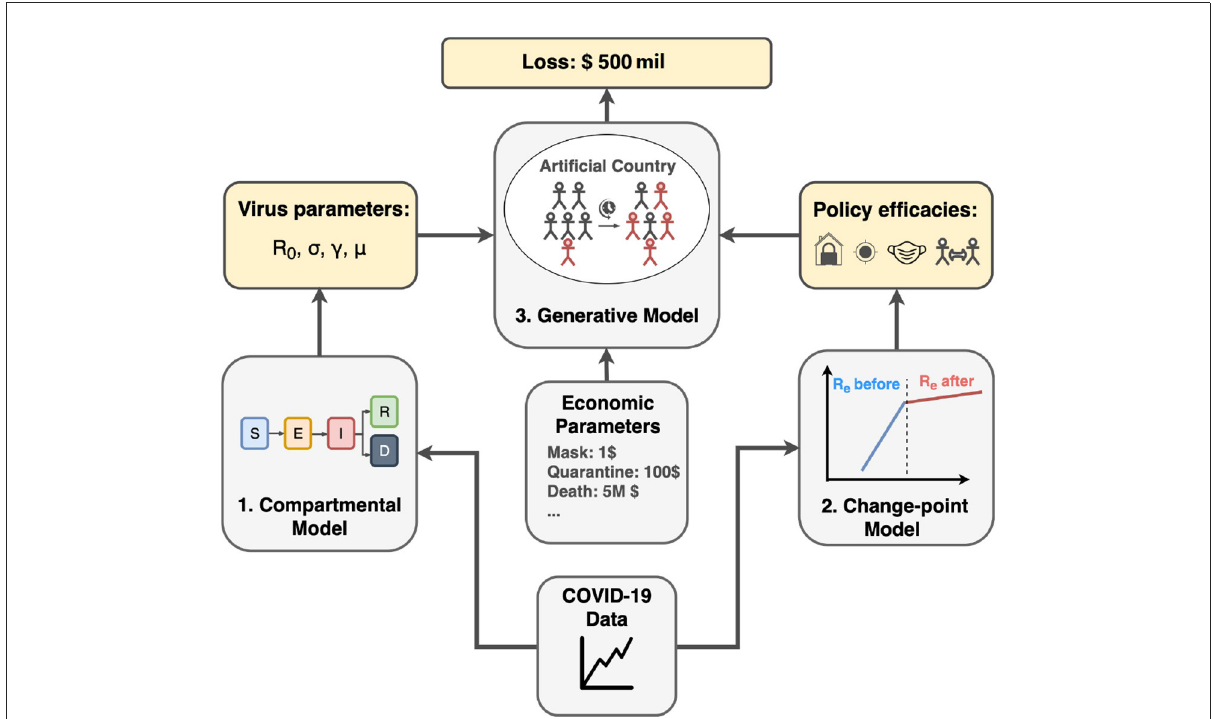
Figure 1, our approach has three major components: 1. Infer COVID-19 statistics by the compartmental model (Section 4). 2. Estimate policy strengths by the change-point model (Section 5). 3. Simulate virus in the context of policy